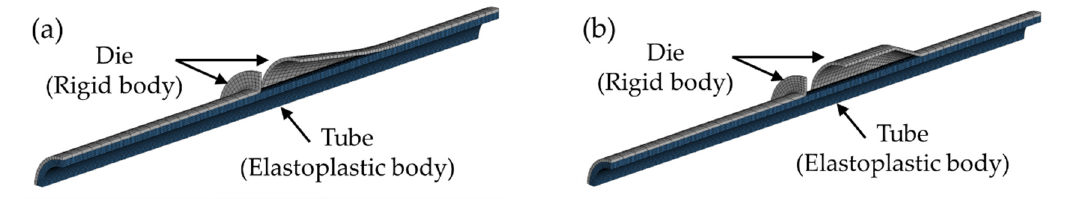
Figure 10. Schematic of the finite element (FE) model: ( a ) FE model for the taper-shape warm THF; ( b ) FE model for the cylinder-shape warm THF. Table 2. Mechanical properties of the small-diameter ZM21 magnesium alloy tube used in FEM.